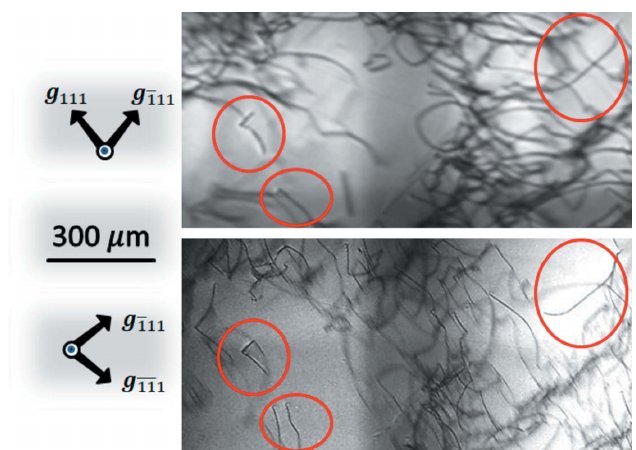
Figure 6 X-ray topographs of a germanium slab taken by ( a ) simultaneous 111 and (cid:2) 1111 reflections and ( b ) simultaneous (cid:2) 1111 and (cid:2) 11 (cid:2) 111 reflections with deformation correction where dislocation configurations circled in red in ( a ) and ( b ) correspond to each other.